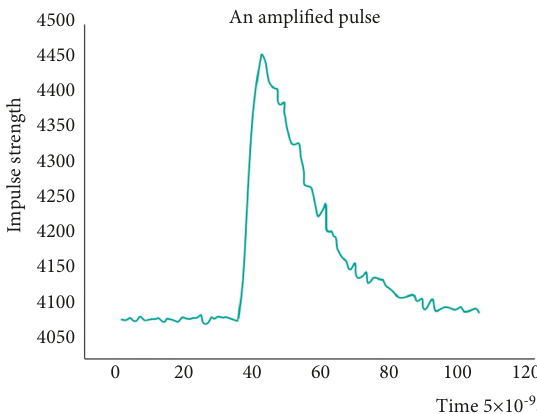
Figure 2: The enlarged part of the pulse signal.